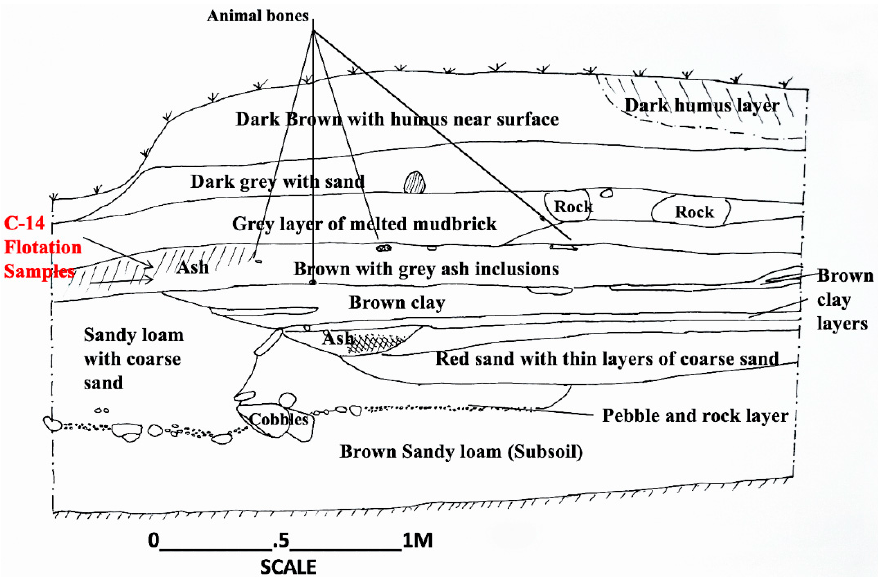
Figure 4. Archaeological Stratigraphy at Settlement 1 (EJS1): A section of a house pit. South facing profile.